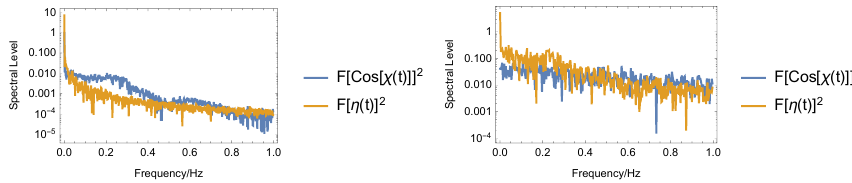
Figure 4 . Power spectra associated to the trajectories in the (cid:17) ( (cid:28) ) ; cos( (cid:31) ( (cid:28) )) plane displayed in (cid:12)gure 3 for the one-kink space time. Left we have E = 0 : 05 and on the right E = 5 : 0.